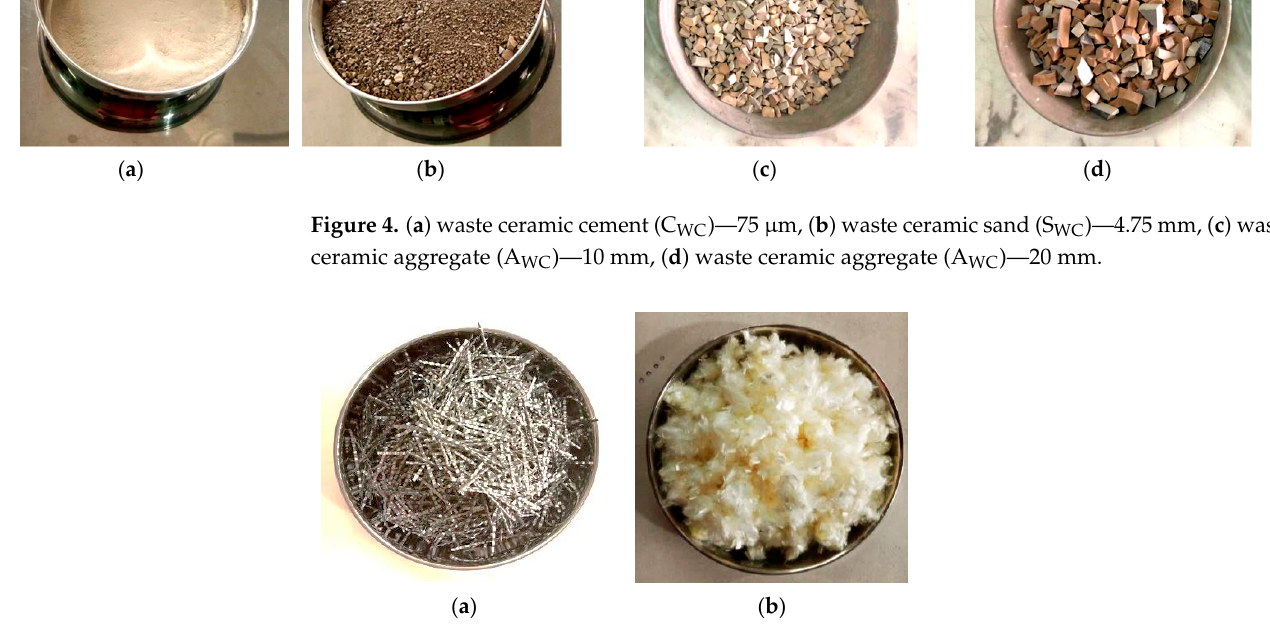
Figure 5. Metallic and non-metallic fiber: ( a ) crimped steel fiber (CR) (60 mm) ( b ) polyvinyl alcohol fiber (PVA) (12 mm).